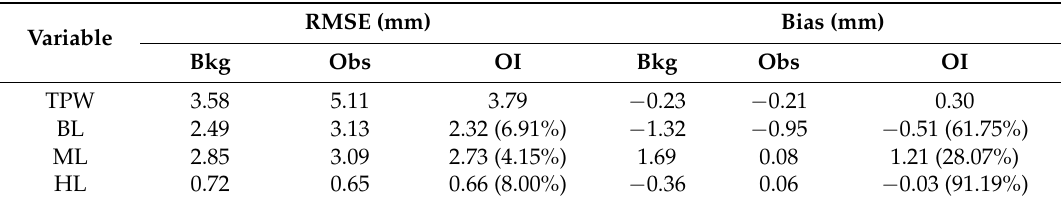
RMSE; ( Right ) PW bias. The percentages in brackets indicate improvements made over background through the application of